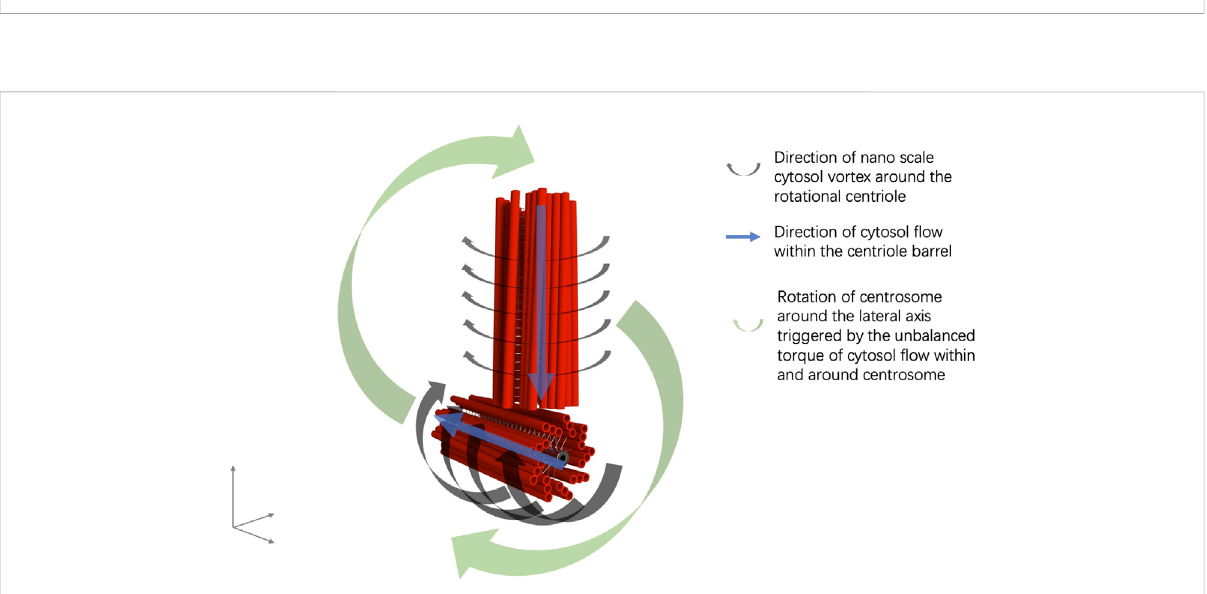
FIGURE 2 Illustration of centrosome rotation in correlation with cytosol fl